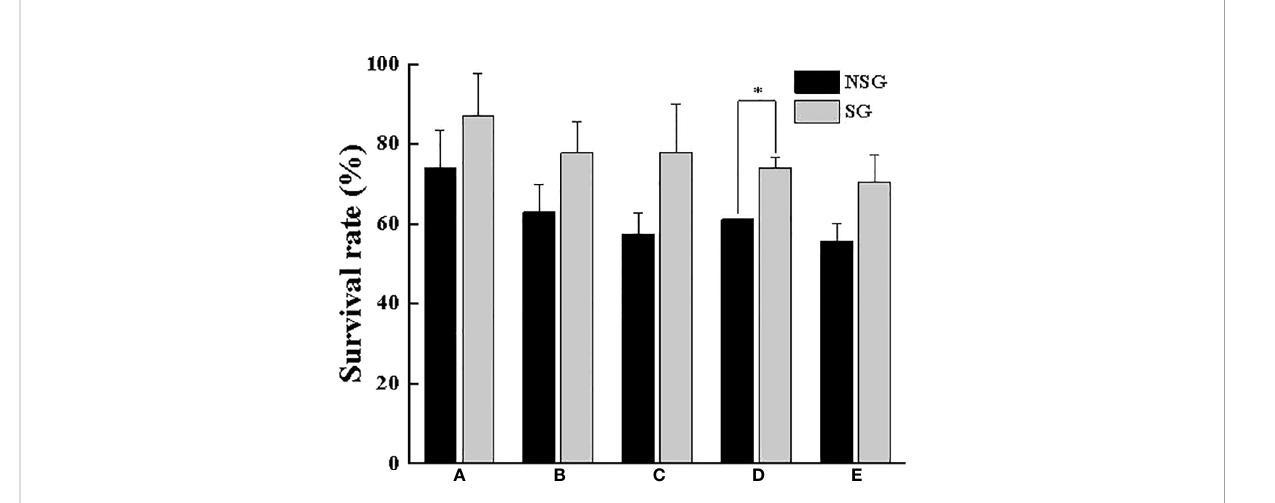
FIGURE 8 Survival rate of swimming crab with different body weight between NSG and SG. “ * ” indicates signi fi cant difference ( P <